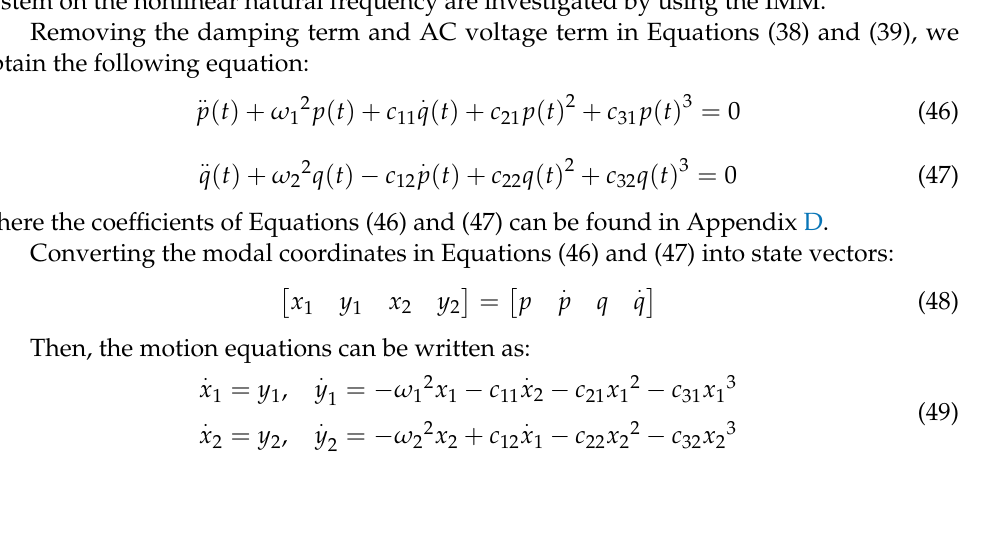
Figure 11. Effects of bias DC voltage asymmetry in the drive and sense directions on the